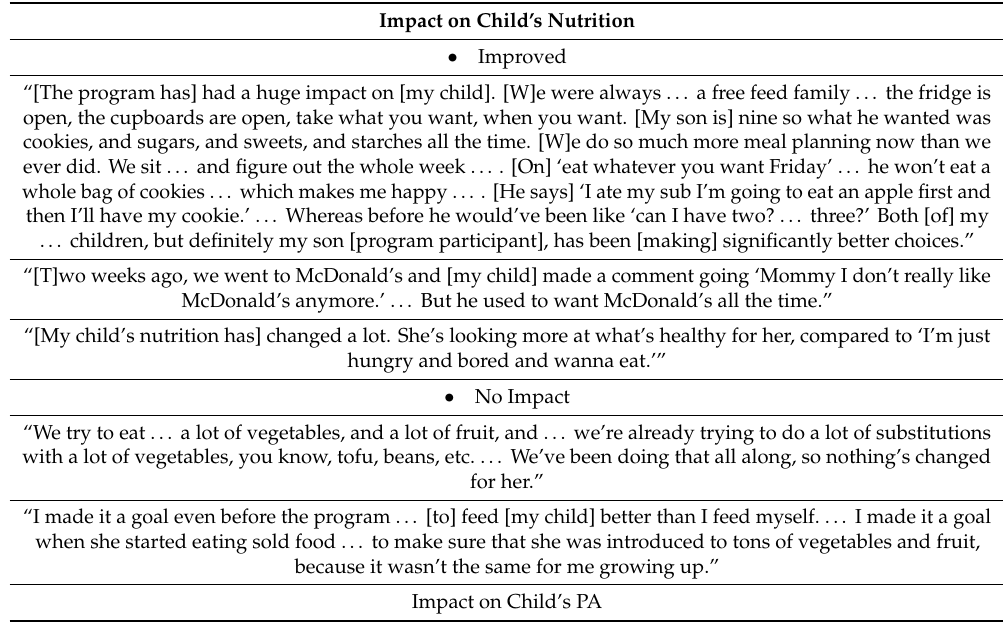
Table 9. Corroborative Quotations for Post-Intervention Themes and Sub-Themes (Intervention